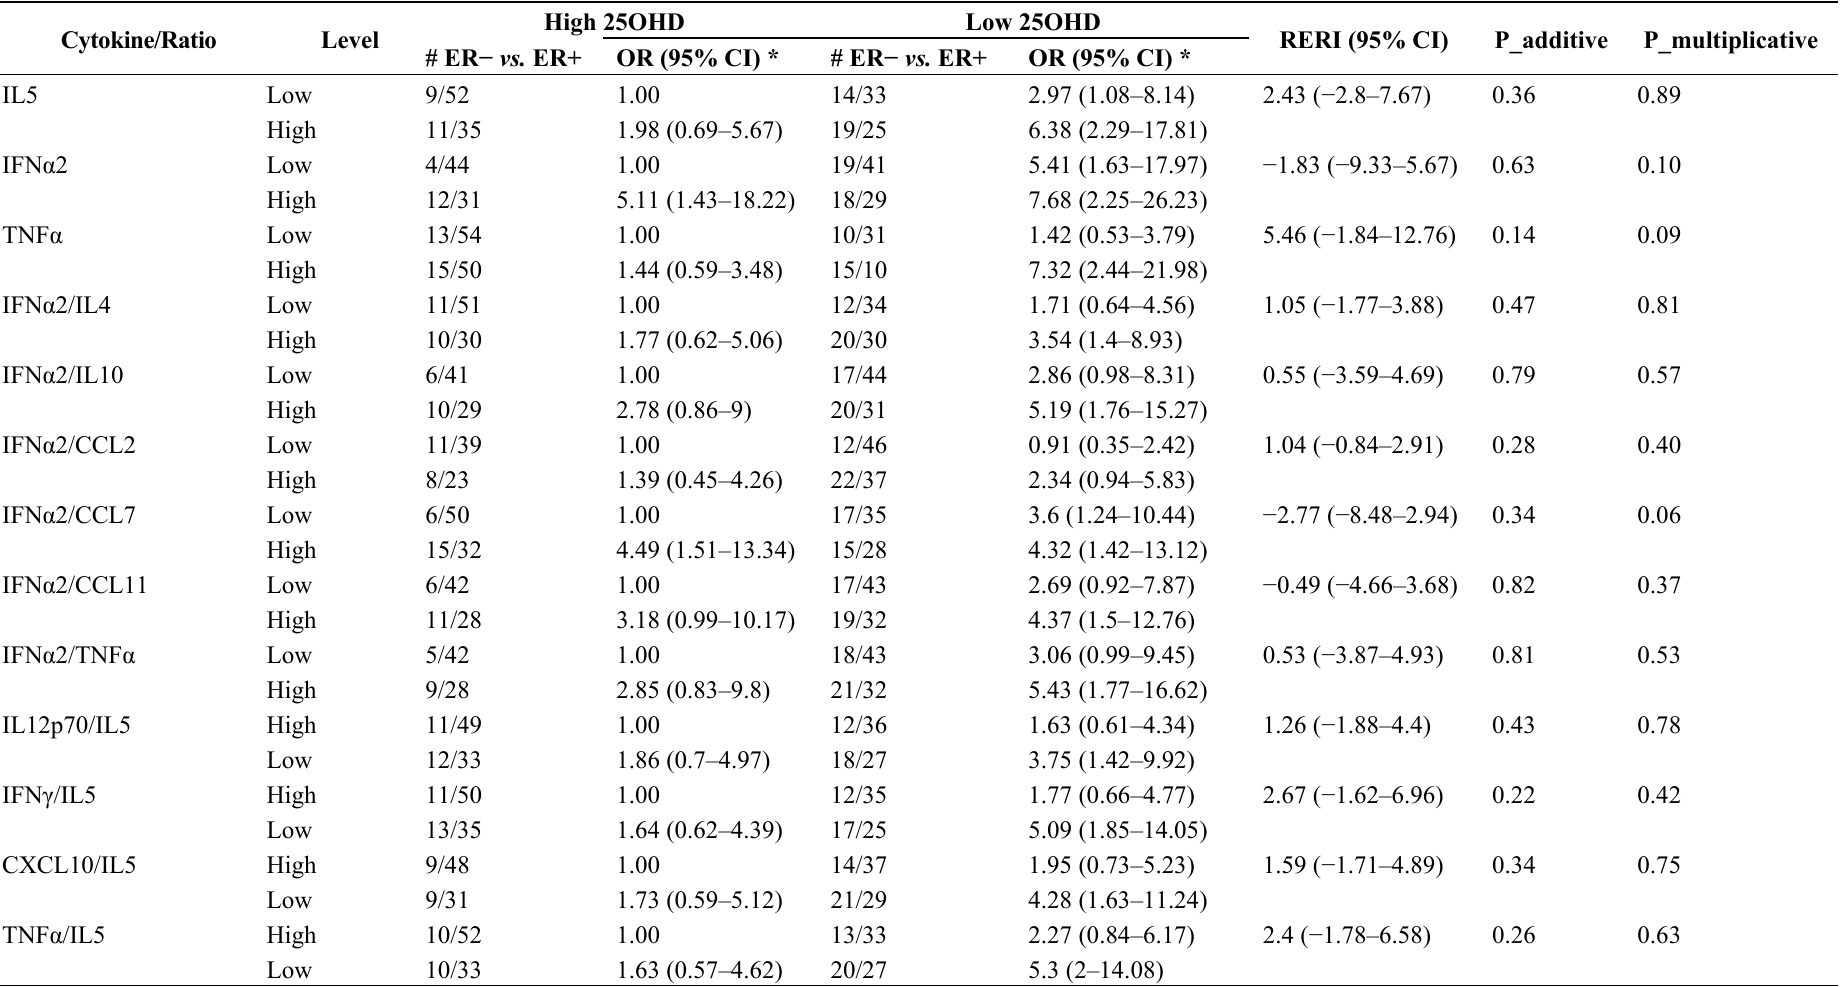
Table 4. Combined effects between blood levels of 25OHD and cytokines on the estrogen receptor (ER) negative status in premenopausal breast cancer